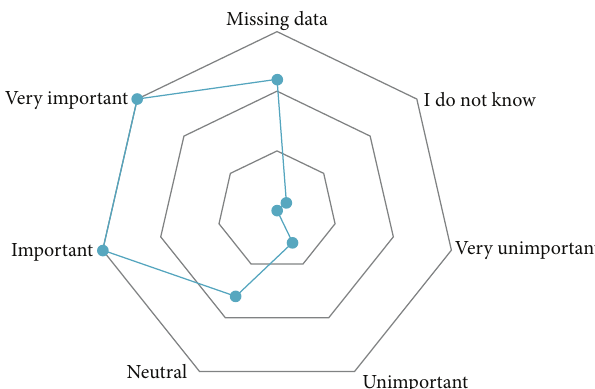
Figure 2: Responses to the following question: How do you feel about a statement on RSV palivizumab use in guidelines/protocols for management of children with DS? The responses are shown in relation to each other.